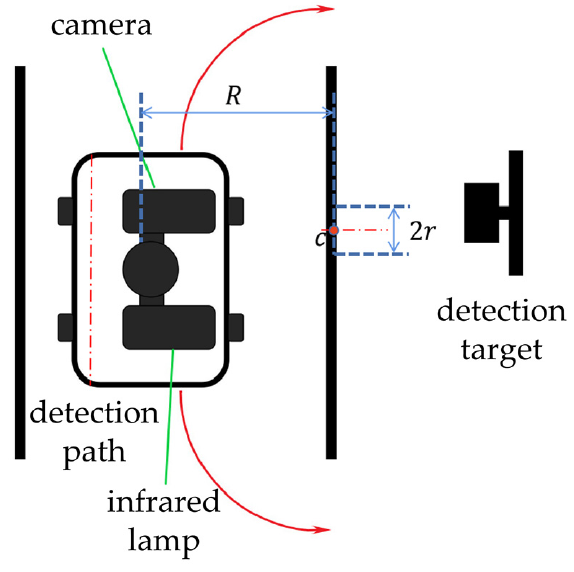
Figure 12. Motion diagram of robot pose adjustment.